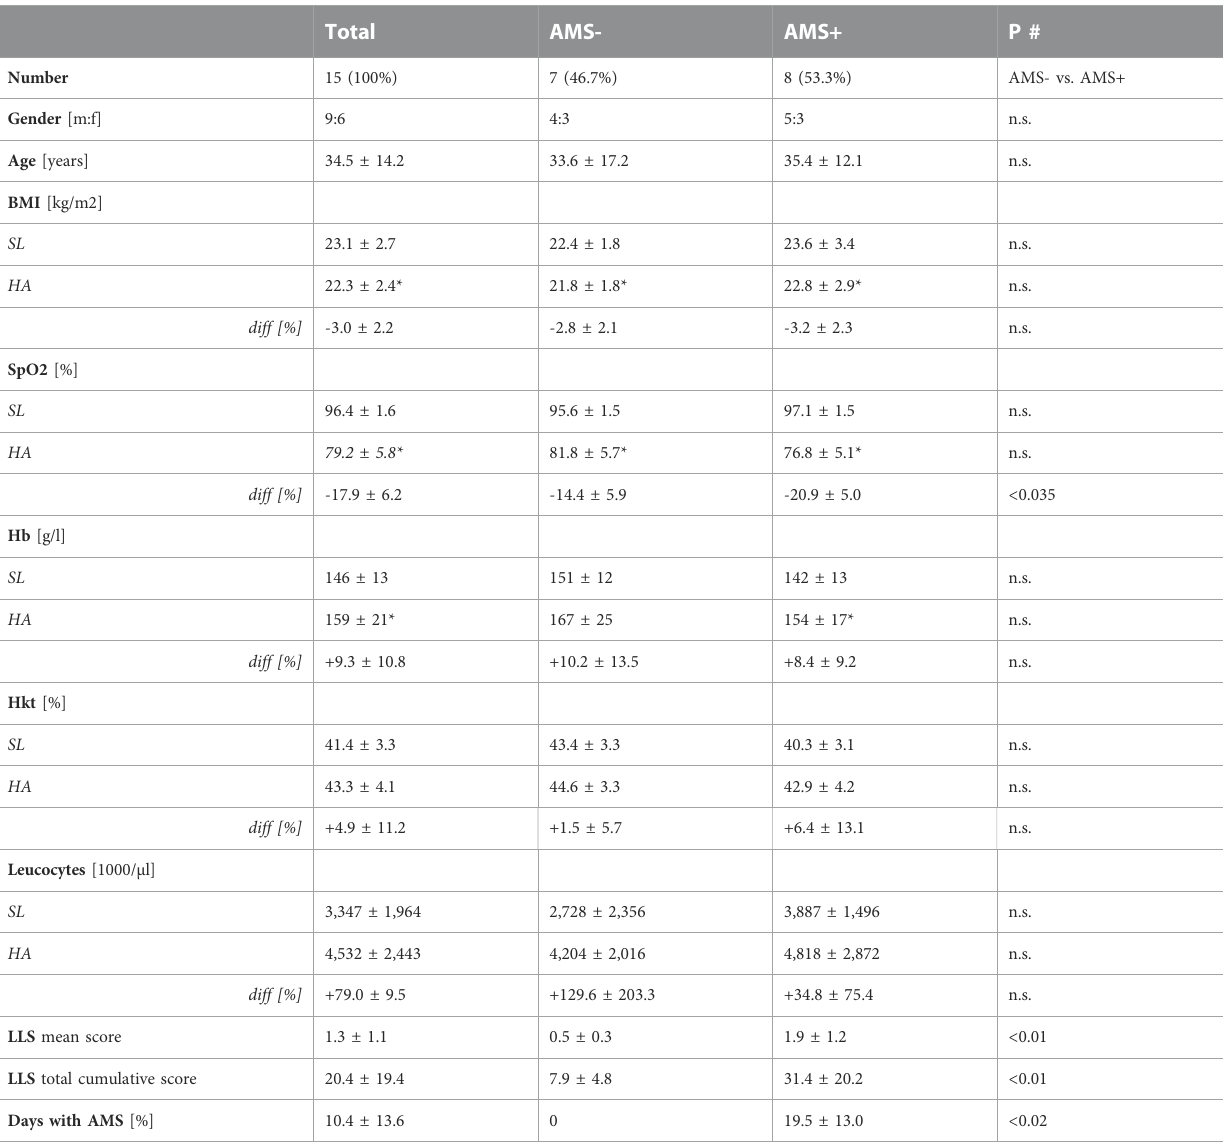
TABLE 1 Clinical characteristics of study participants at sea-level (Bangor) and 1 day after arrival at high-altitude in 5,050 m (Hidden Valley Base Camp, HVBC) according to AMS groups. Data are given as number [%] or mean ± standard deviation. * p < 0.01 for intra-group comparisons (SL vs. HA) tested by paired t -test. #inter-group comparison (AMS- vs. AMS+) at sea-level (SL) and at high-altitude (HA) using unpaired t -test test for continuous variables and Fisher exact test for categorical